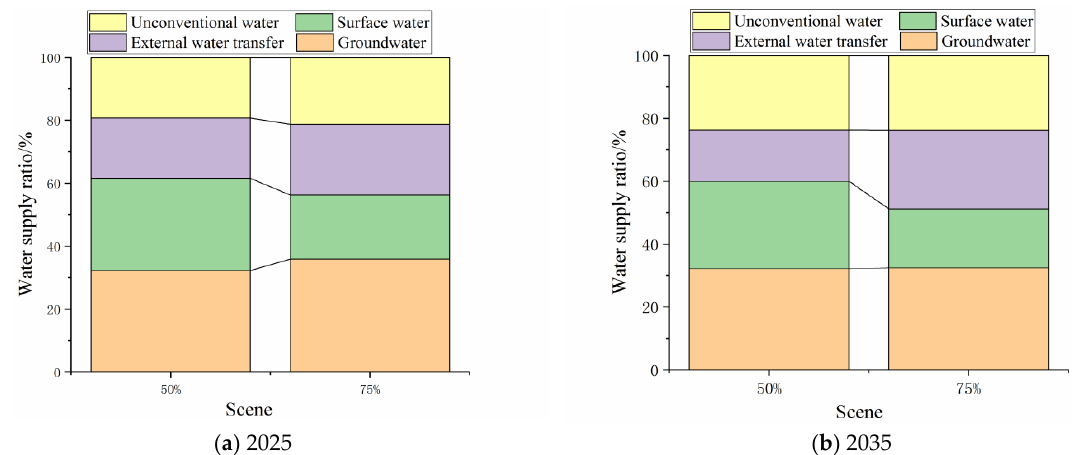
Figure 4 reflects the proportion of available water supply of each water source under dif- ferent scenarios in 2025 and 2035. Due to the prominent phenomenon of rain-fed agricul- ture in the region, agricultural water shortage is essentially normal, and 2020 was a dry year, making the current regional water supply predicted under the flat dry scenario in different planning years lower than the total water demand.